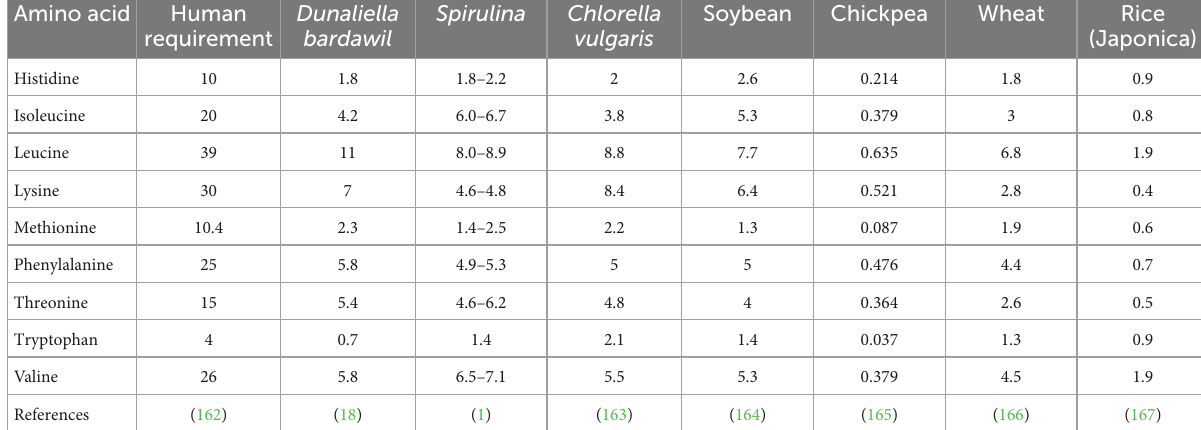
TABLE 1.2 Amino acid content comparison between human dietary requirements, algae, and highly produced traditional crops. Amino acid Human Dunaliella Spirulina requirement bardawil